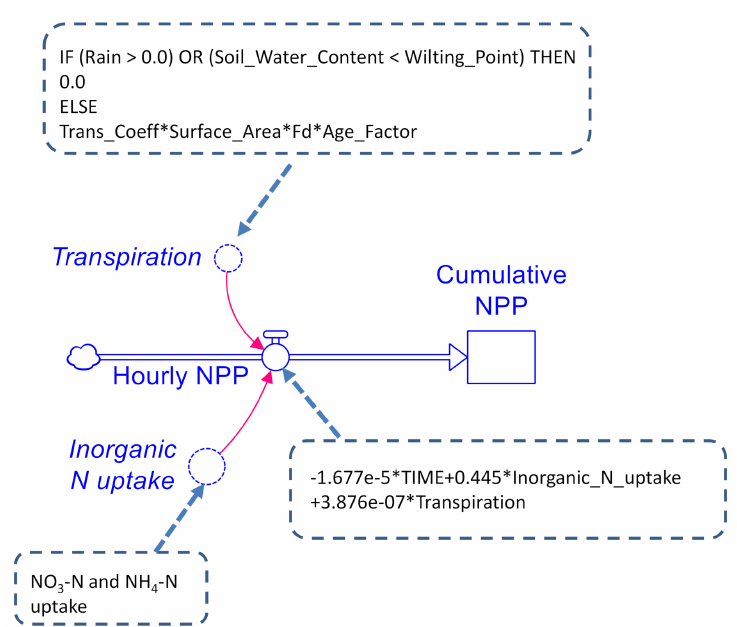
Figure 3. A detailed explanation of the STELLA model.